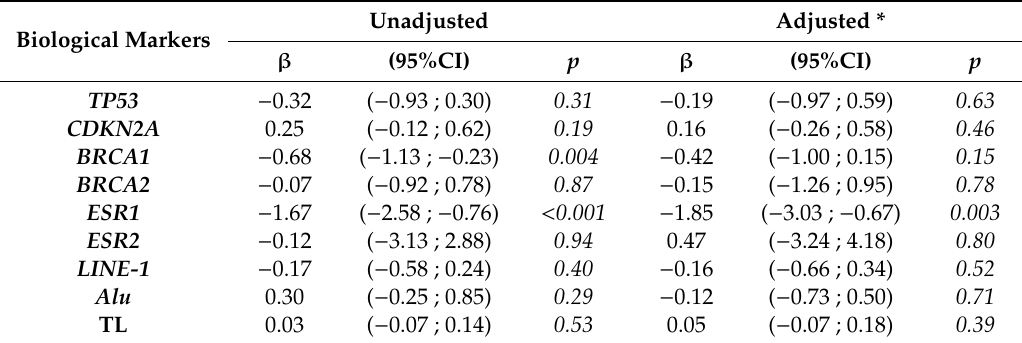
Table 2. Association between night shift work [current ( N = 46) vs. non-night shift workers ( N = 51)] and gene-specific methylation, methylation of repetitive elements, and telomere length. Biological Markers